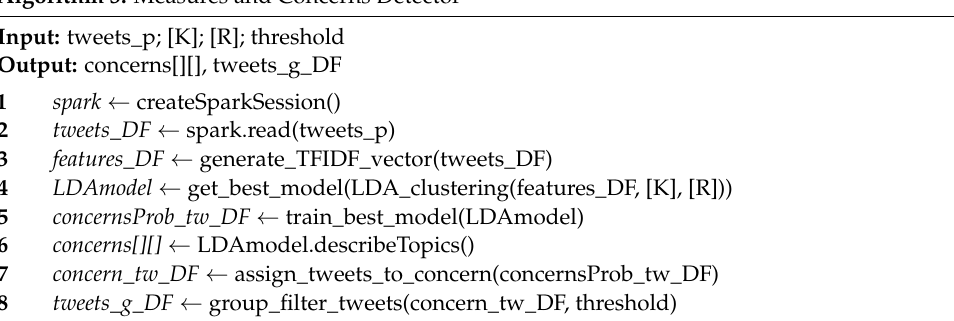
Algorithm 3: Measures and Concerns